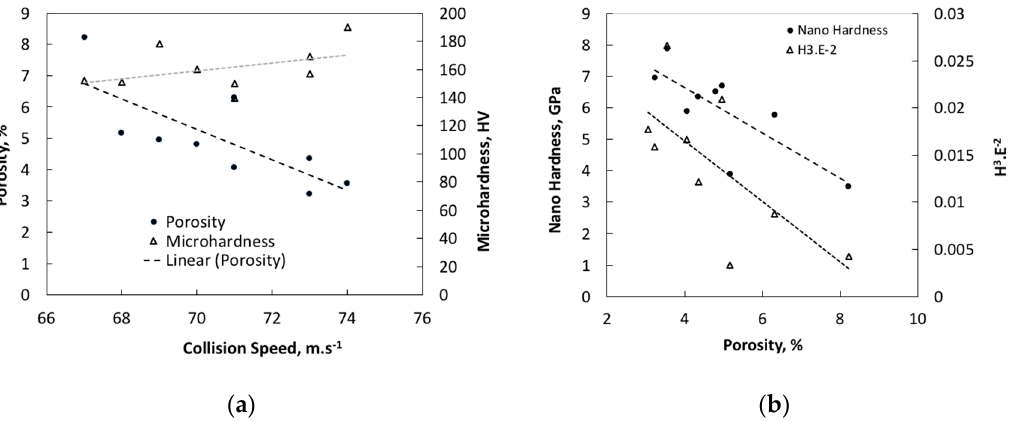
Figure 4. ( a ) Porosity percentage and microhardness vs. collision velocity. ( b ) Nanohardness and plastic deformation (H 3 /E 2 ) vs. porosity percentage (the trend lines are shown as a visual aid).